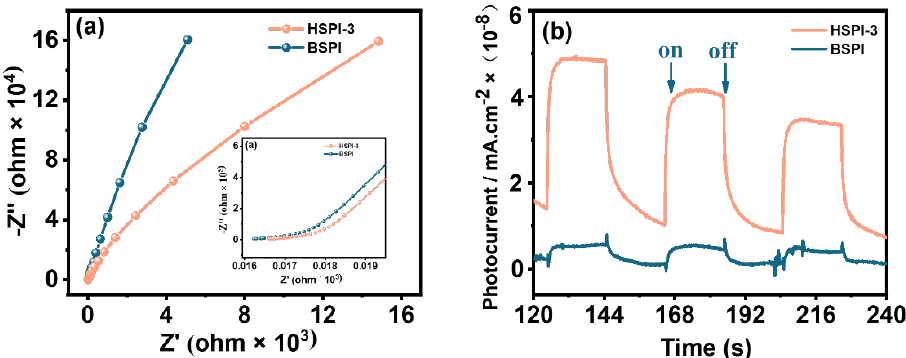
Figure 10. ( a ) EIS Nyquist plots of electrochemical impedance spectroscopy with BSPI and HSPI-3 composite in the dark. ( b ) Photocurrent – potential curves of BSPI and HSPI-3 composite electrode in the 0.5 mol L −1 Na 2 SO 4 aqueous solution under full arc light irradiation.